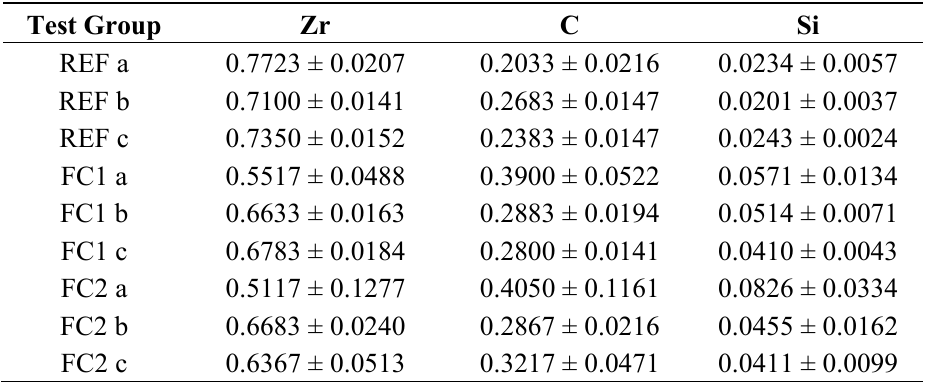
Table 2. X-ray photoelectron spectroscopy (XPS) results: mean relative elemental intensities and corresponding standard deviations of Zr, C and Si of the test groups determined from the XPS line intensities (areas).